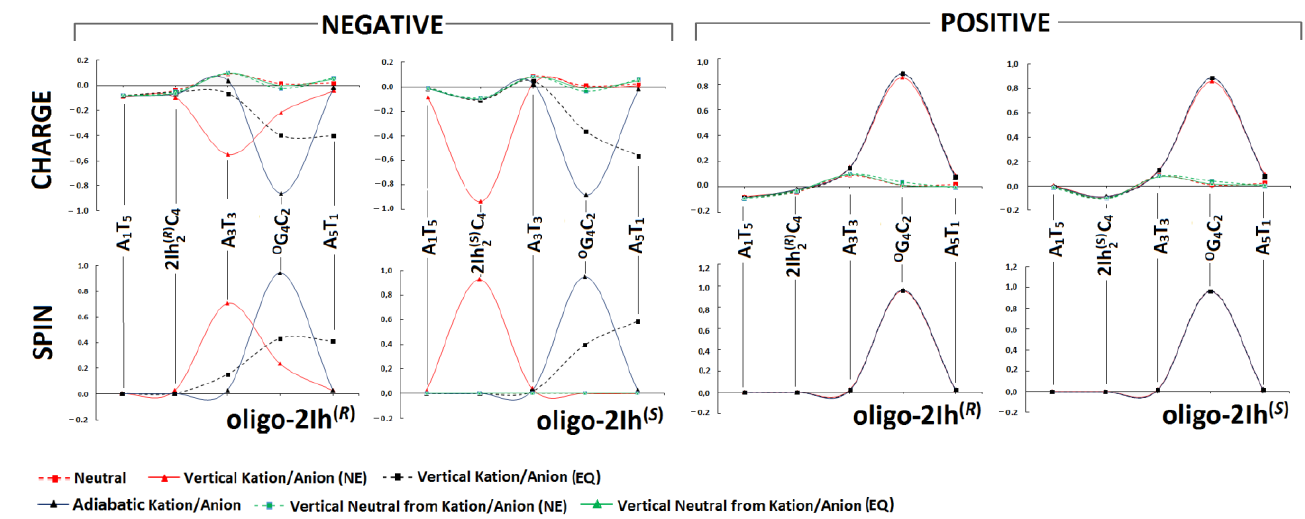
Figure 3. Spin and charge distribution within oligo-2Ih ( S ) and oligo-2Ih ( R ) . The ds -oligos vertical, or adiabatic, anion and cation forms calculated at the M062x/6-31++G** level of theory in the aqueous phase, by using the non-equilibrated (NE) and equilibrated (EQ) solvent-solute interaction. Only the stacked base pairs were taken into consideration. The raw data is given in Table S1.